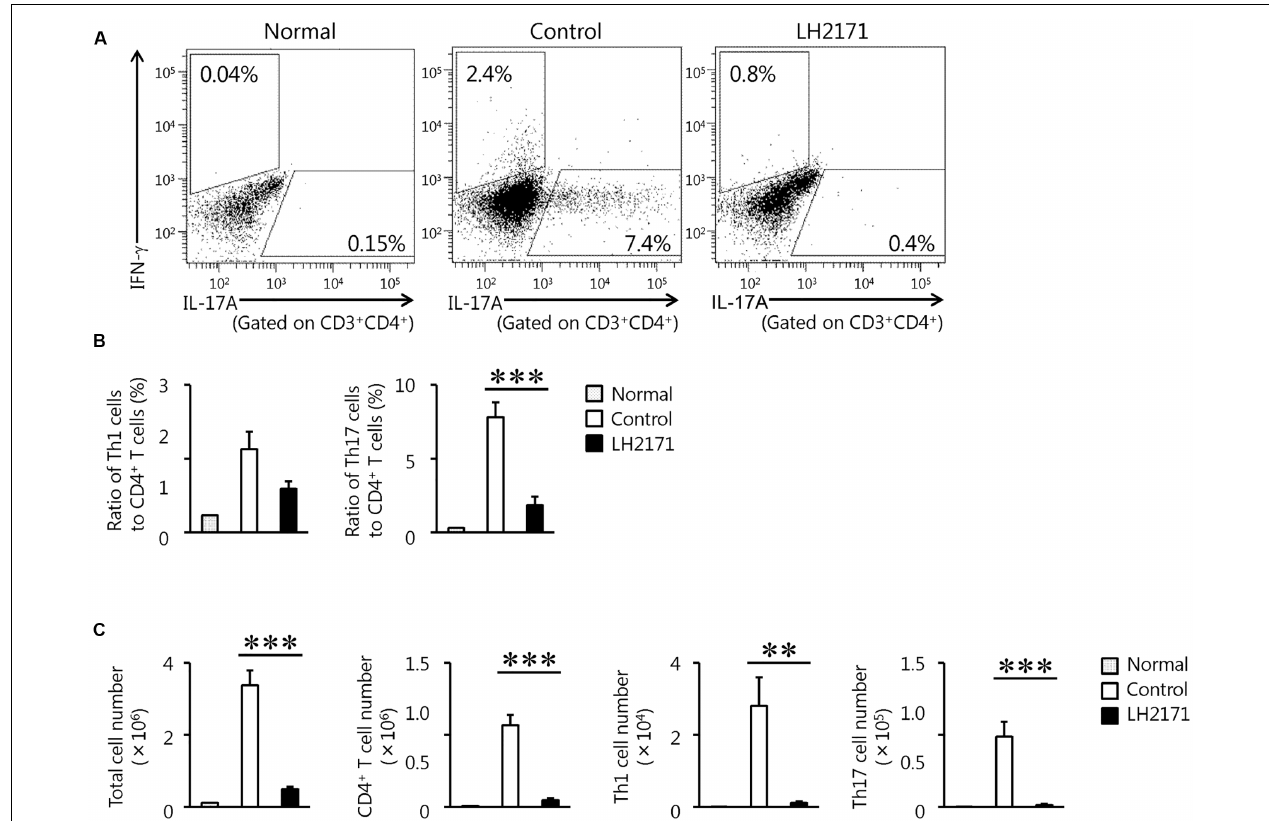
FIGURE 3 | Reduction of the population of pathogenic immune cells in the spinal cord by LH2171 administration at the peak stage of EAE. The spinal cord was collected from normal mice and EAE mice treated with or without LH2171 on day 14, at the peak stage of disease activity. Immune cells isolated from the spinal cord were analyzed by flow cytometry. CD3 + CD4 + IFN- γ + cells were identified as Th1 cells and gated with an upper-left trapezoid and CD3 + CD4 + IL-17A + cells were identified as Th17 cells and gated with a lower-right trapezoid (A) . The ratio of Th1 and Th17 cells to CD4 + T cells (B) or the numbers of total lymphocytes, CD4 + T cells, Th1 cells, and Th17 cells (C) were determined. Data are shown as a means ± SEM (normal group, n = 2; control group, n = 12; LH2171-treated group, n = 11). LH2171-treated mice were compared with control mice by Student’s t -test ( ∗∗ P < 0.01, ∗∗∗ P <